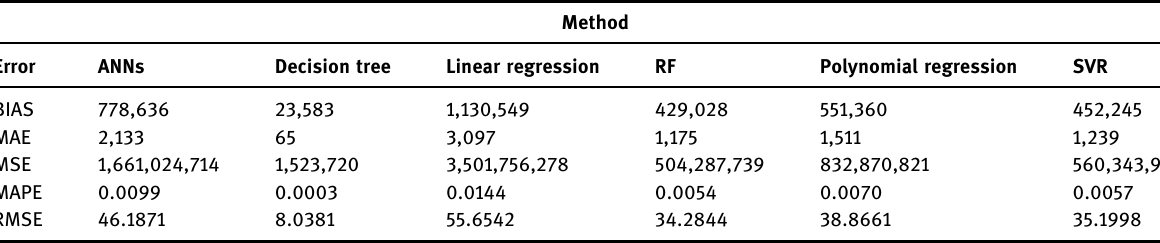
Table 11: Error measures obtained under the ANN and ML